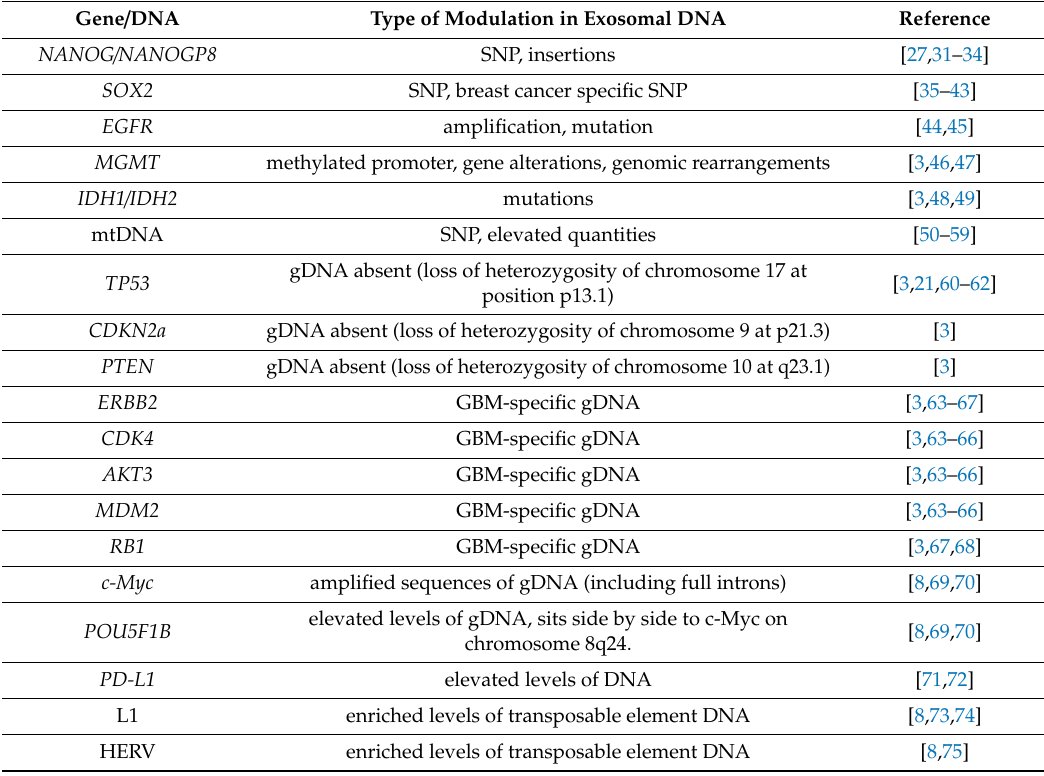
Modulated genes and transposable element DNA sequences associated with brain tumor-secreted exosomes. The details of each type of DNA and their use as brain cancer biomarkers are compiled in the following